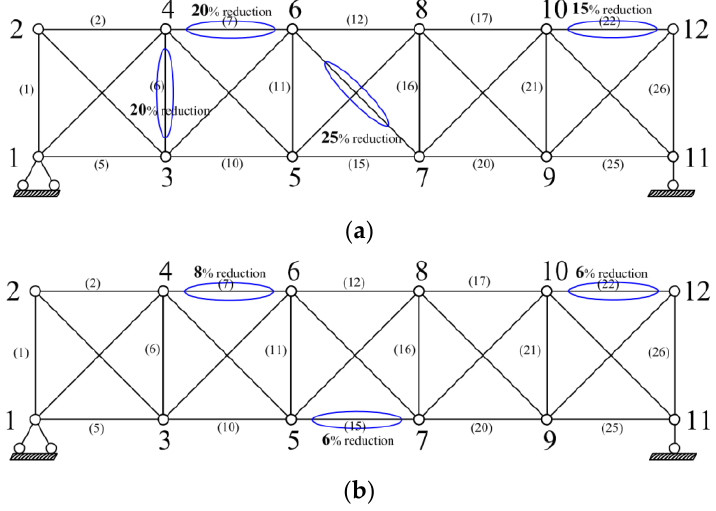
Figure 10. ( a ) case 1: complex damage case with multiple damage of members. ( b ) case 2: small damage case with multiple damage of members.